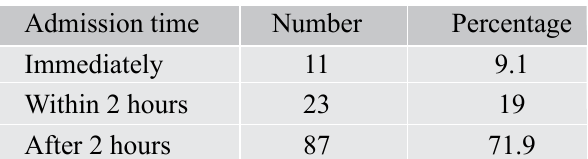
Table I: Snake bite to hospital admission time